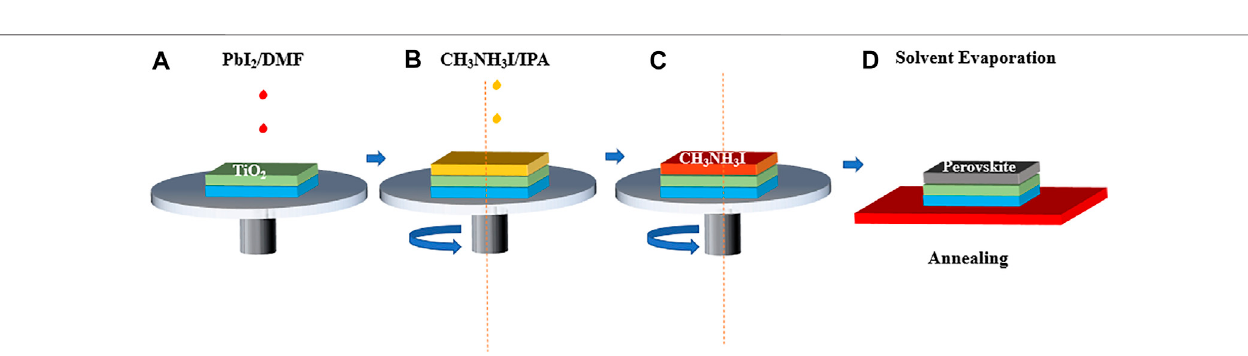
Frontiers in Materials |